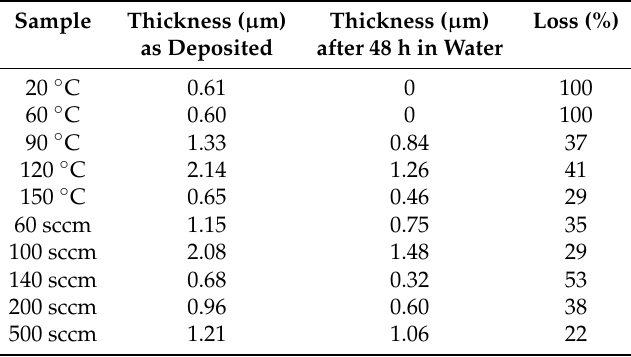
Table 1. The thickness and stability of POx films deposited at different substrate temperatures and at different flow rates through the monomer. The samples marked with temperature were deposited at this substrate temperature and the flow rate of 100 sccm. The samples marked with flow rate were deposited at this flow rate and the substrate temperature of 120 ◦ C.